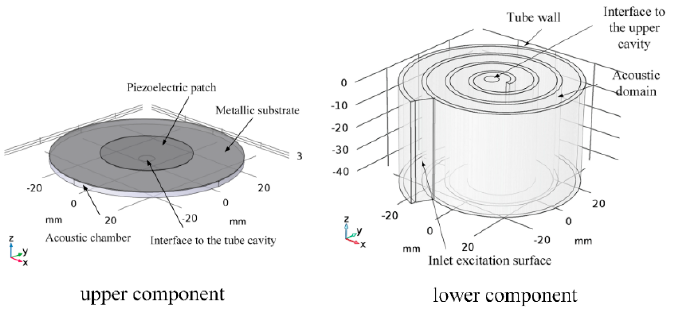
Figure 21. Schematic diagram of the helix structure AEH prototype. Reproduced with permission from [60]; published by American Institute of Physics, 2018.